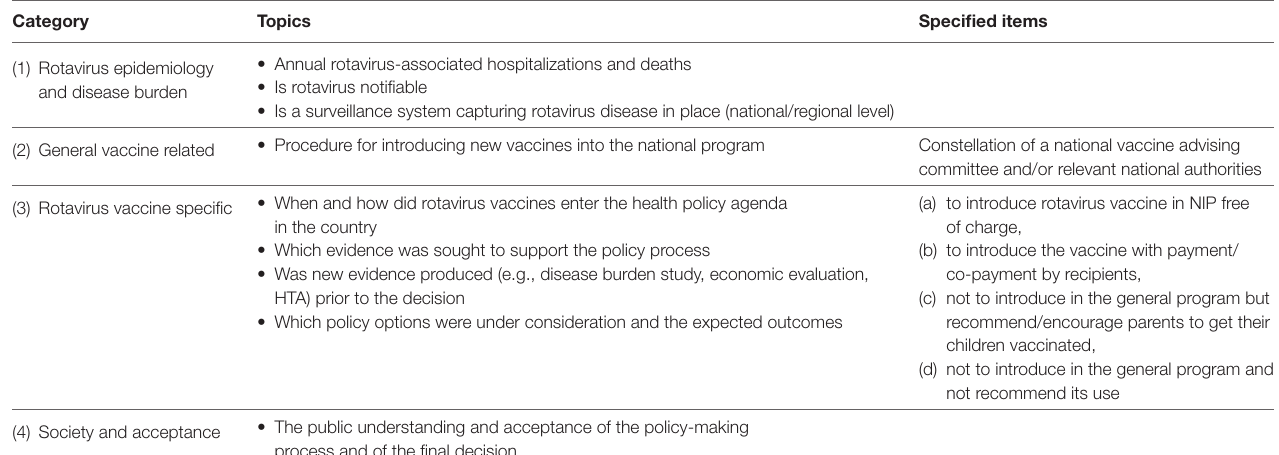
category Topics Specified